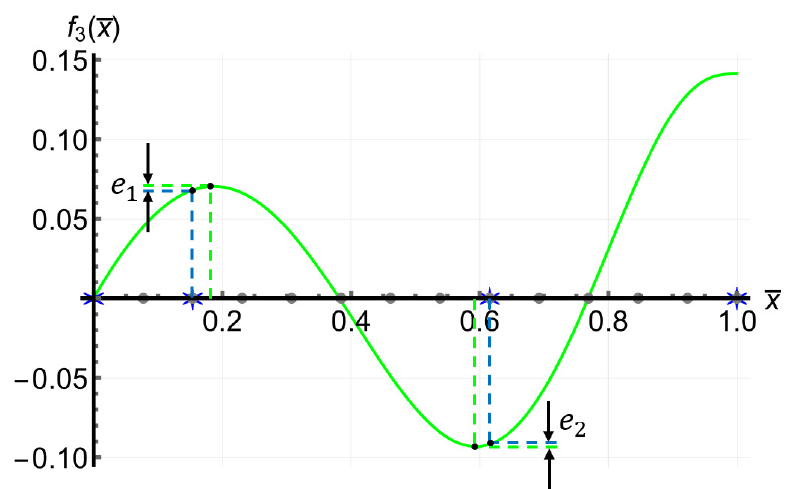
Figure 13. Example of numerical error in the assessment of the O.V.D. for the third mode excitation and c = 3. The gray points highlight the position of each PP edge (13 PP were considered). The blue stars represent the FEM calculated O.V.D., the solid green line represents the function f 3 ( ¯ x ) for c = 3. The values e 1 and e 2 represent the discrepancies among the analytical and numerical δ L p . The total error was always less than 3%.